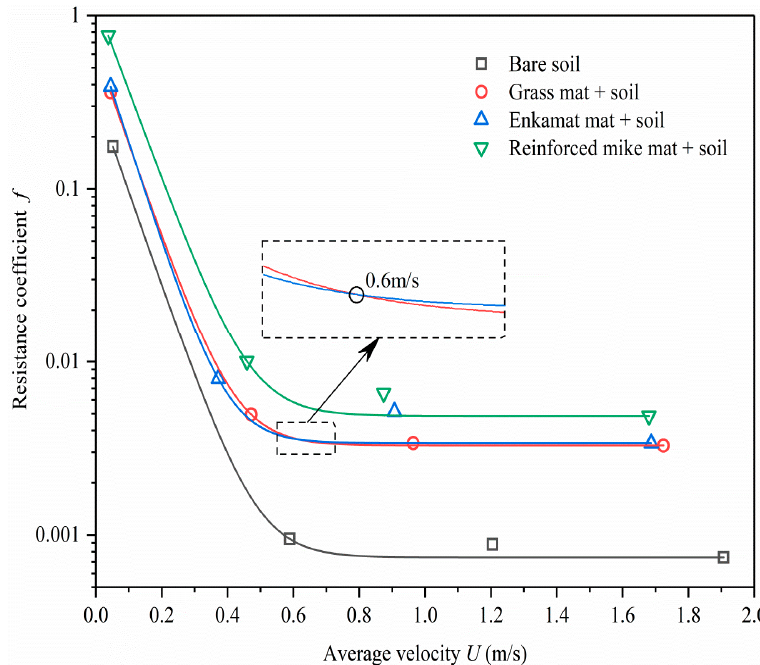
Figure 4. Trend lines for distribution of resistance coefficient f of various slope protection materials with different average velocities.